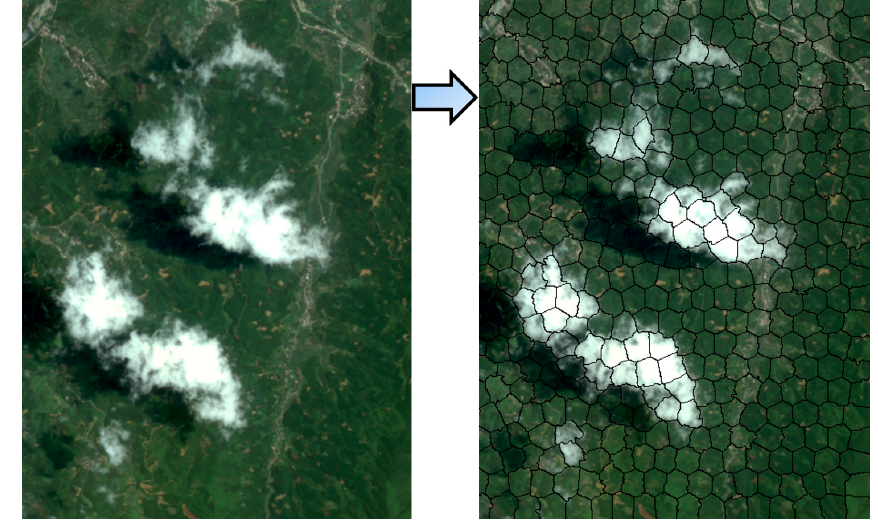
Figure 3. Superpixel segmentation by SLIC.